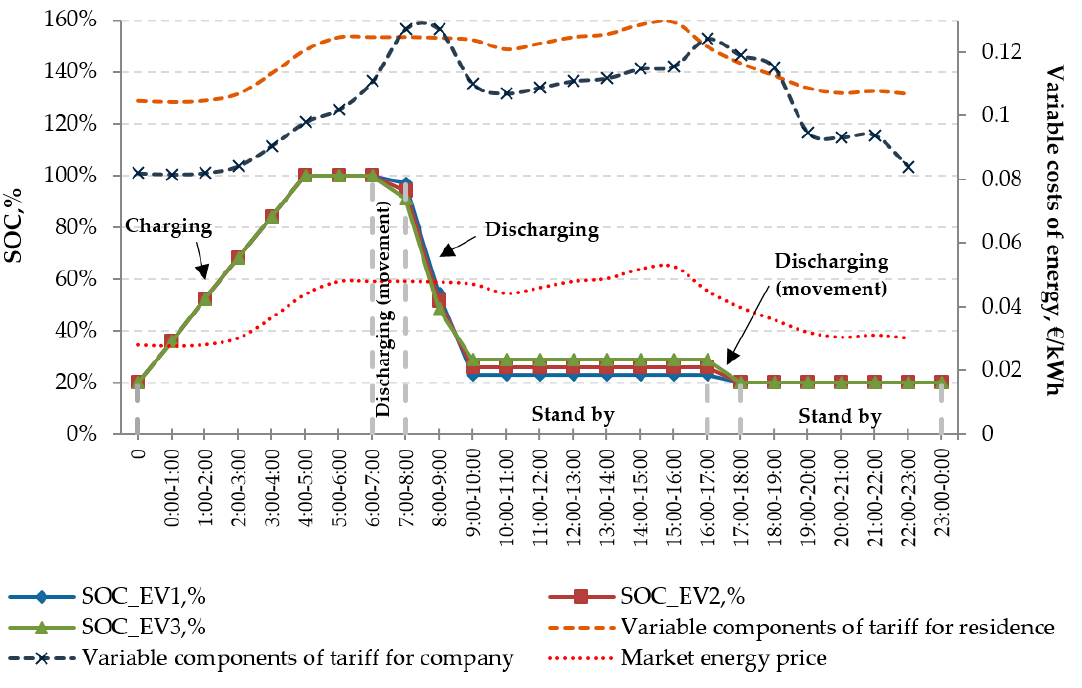
Figure 3. EV’s charging/ discharging profile (6 January 2018), applying the existing billing system.